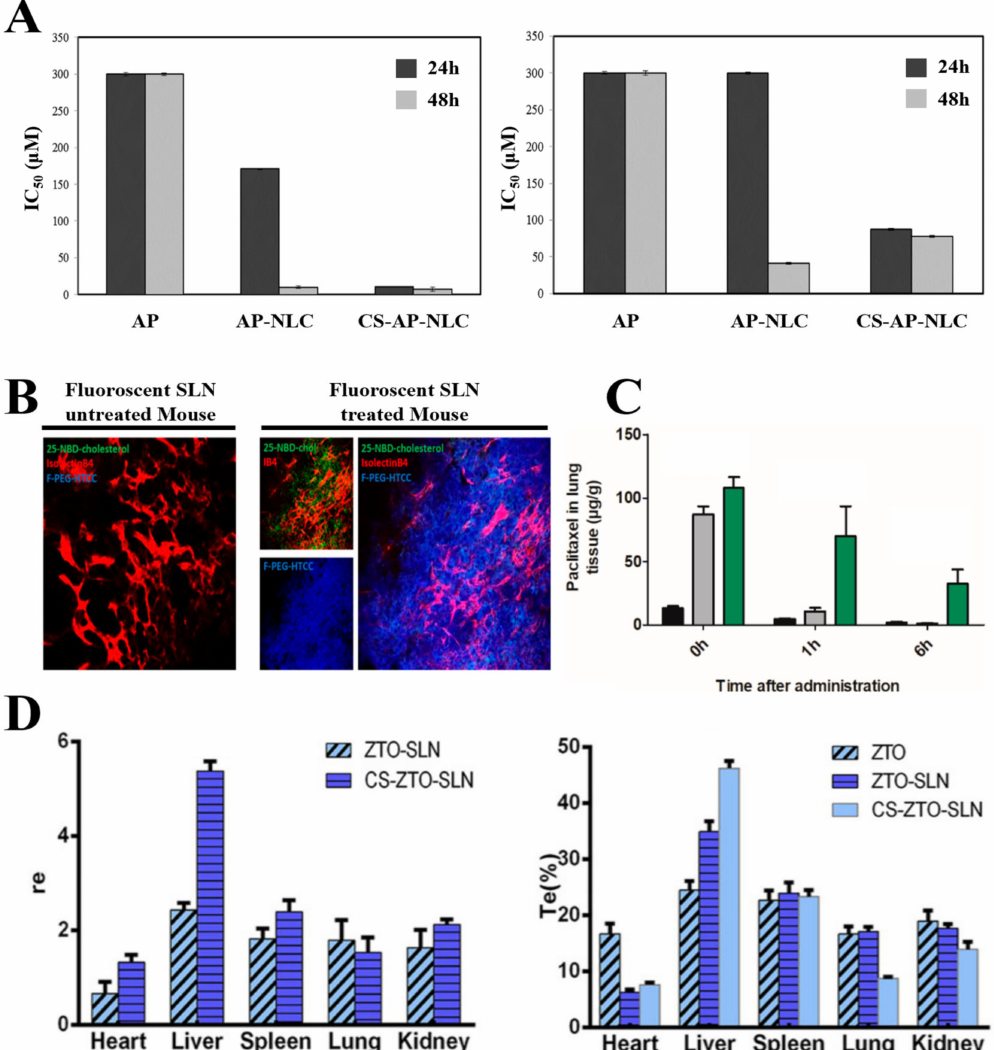
Figure 6. Functionalization of LNPs through chitosan coating. ( A ) In vitro dose-dependent NLC and CS-NLC cytotoxicity profiles on ( left ) Caco-2 and ( right ) Hela cells. ( B ) In vivo tumor distribution of fluorescent-CS-SLN loaded with 25-NBD-cholesterol following inhalation on the M109 model. Confocal images of fluorescent SLN untreated or treated M109 mouse lung. (Red: vessels labeled with isolectinB4), (green: 25-NBD-cholesterol labeling SLN), (blue: Alexa Fluor 405-grafted-F-PEG-HTCC labeling the coating). ( C ) Pulmonary exposure to paclitaxel after administering intravenous (black: Taxol), inhaled (gray: Taxol), and inhaled (green: F-PEG-HTCC-coated SLN). ( D ) The evaluation of chitosan coating’s targeting efficiency in mouse organs, including the heart, liver, spleen, lung, and kidney. The relative uptake ratio ( left ), targeting efficiency ( right ). CS: chitosan coating. Reproduced with permission from [83,127] published by Elsevier, 2015, 2017, 2020, and [130] published by the American Chemical Society,